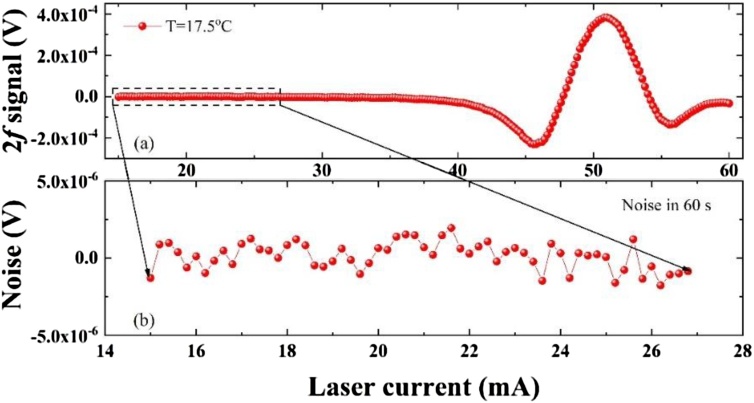
(a) QEPAS 2f signal of H2O detected in laboratory ambient air; (b) Noise obtained at the laser wavelength beyond the H2O absorption line.